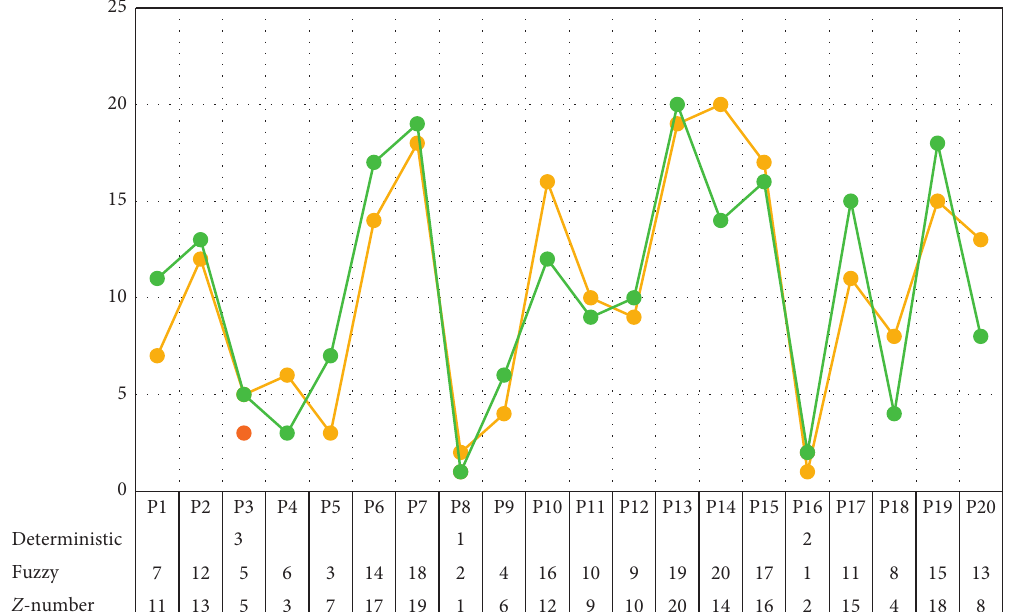
Figure 12: Project ranking results using the VIKOR approach under different scenarios (second example: 20